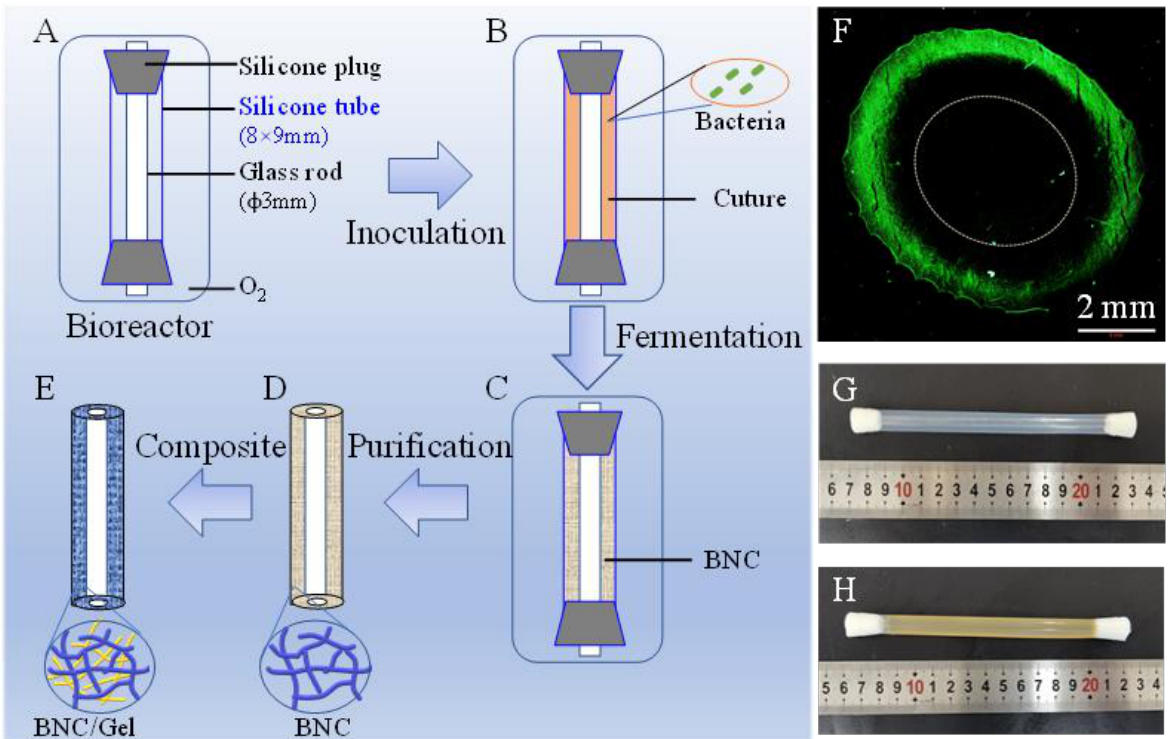
Figure 1. Schematic diagram of production of BNC tube by fermentation, followed by synthesis of BNC/Gel tube. ( A ) The patented device for producing BNC tube; ( B ) inoculation of fermentation broth containing activated bacterial cells; ( C ) formation of BNC tubes in the bioreactor by fermentation; ( D ) BNC tube after purification and its network structure; ( E ) BNC/Gel tube obtained by crosslinking BNC tube and gelatin to form double network structure; ( F ) the distribution of K. xylinus cells in the bioreactor, inspected by using nucleic acid dye staining; ( G ) appearance of the bioreactor; ( H ) a BNC tube formed in the bioreactor.